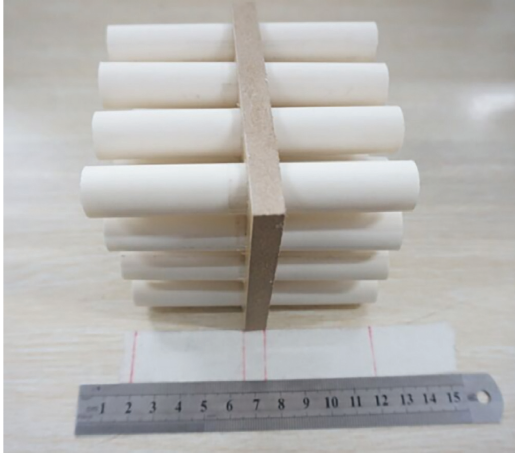
Figure 5: Cube prototypes.